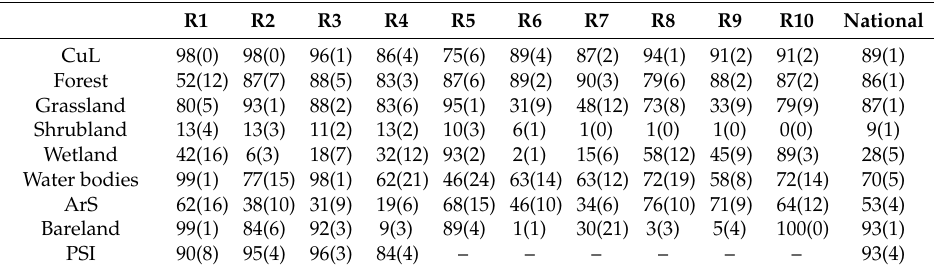
Table A12. Regional producer’s accuracies for nine land cover classes with standard errors (SE) in parentheses when agreement is defined as a match with the primary label.